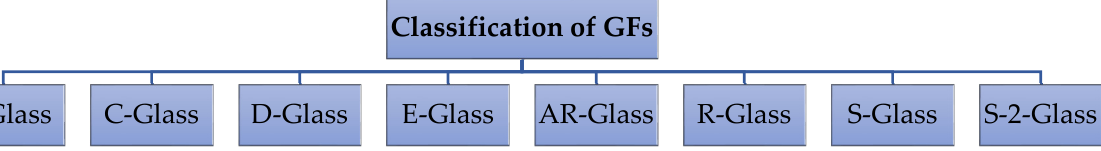
Figure 1. Classification of common glass fibers.